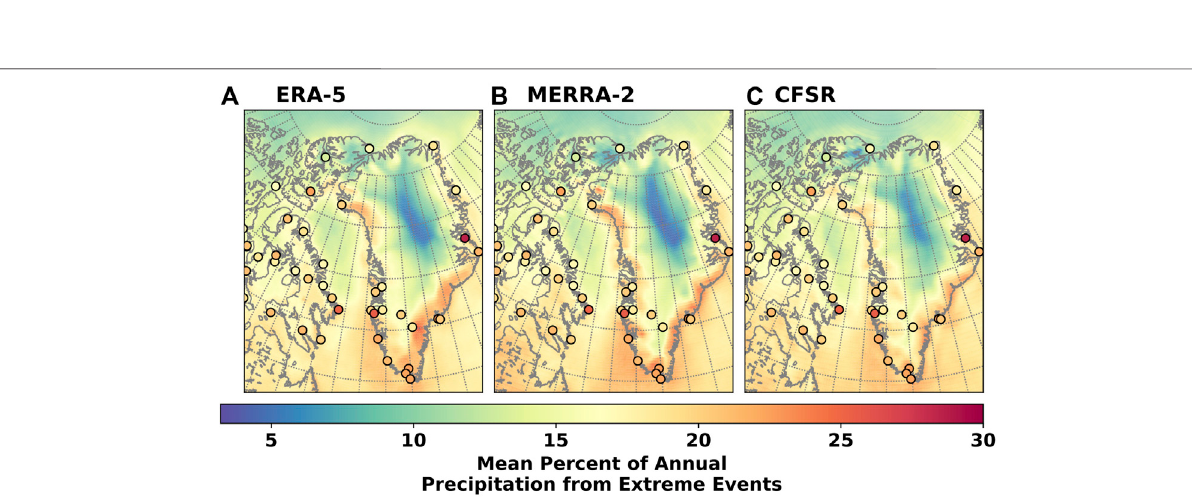
Frontiers in Environmental Science |